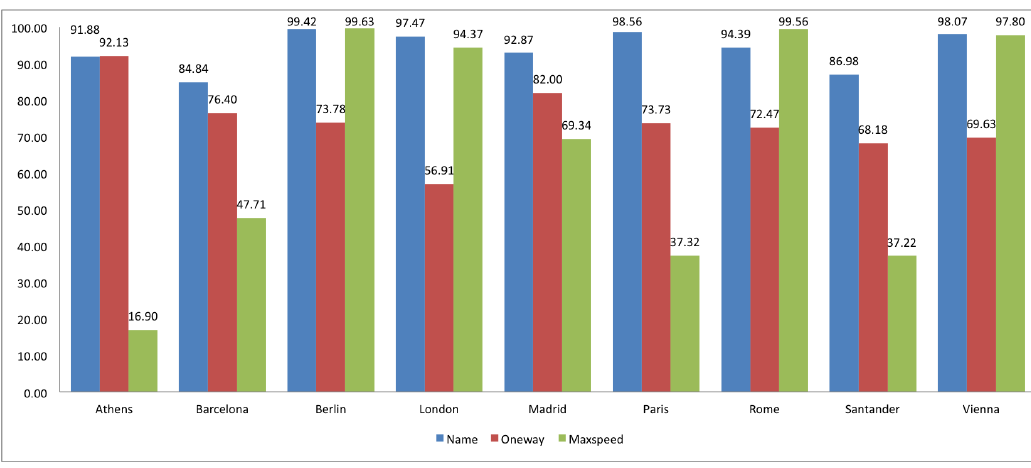
Figure 18. Completeness study in Europe. Percentage of attributes name, oneway and maxspeed in highways.